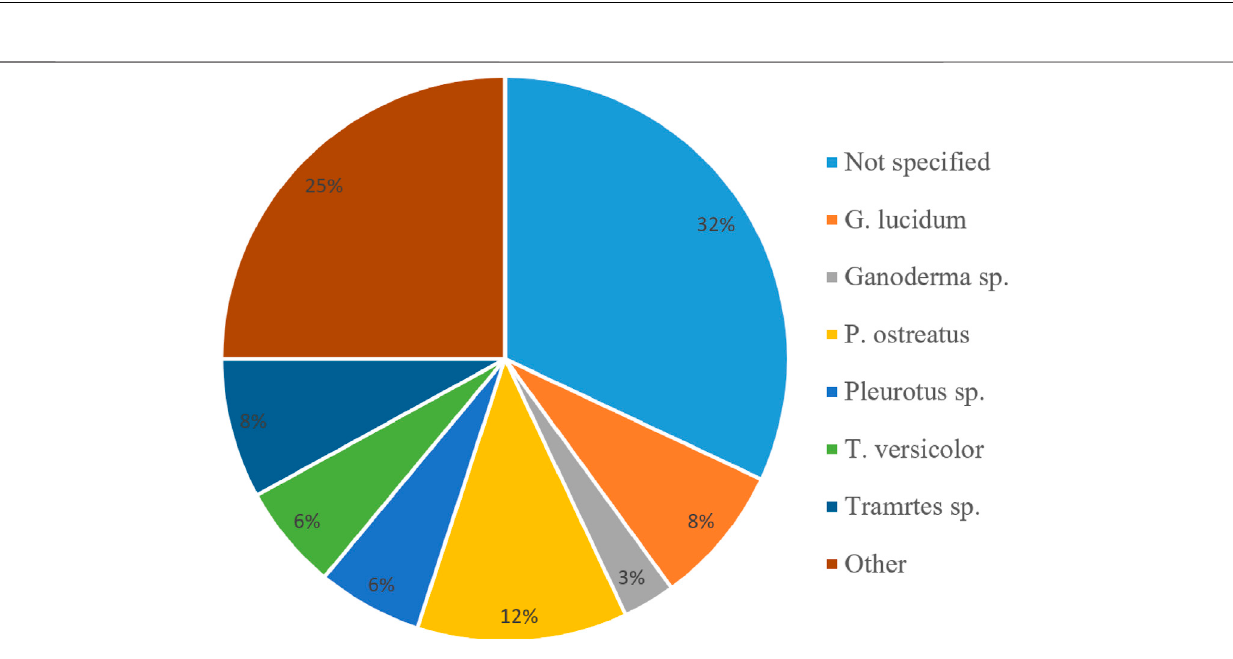
Frontiers in Materials |